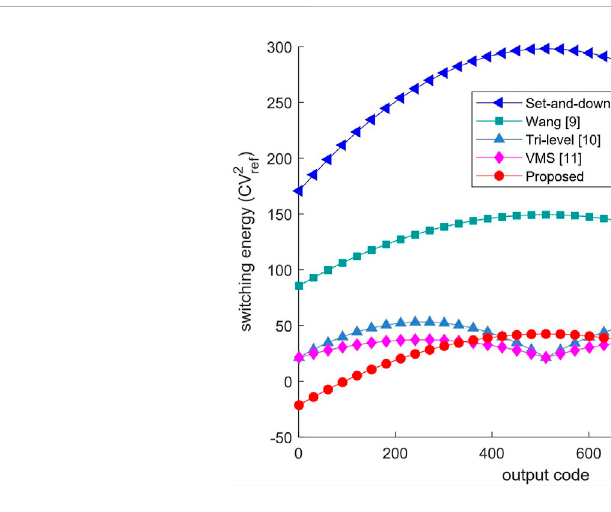
FIGURE 7 Switching energy against output codes.